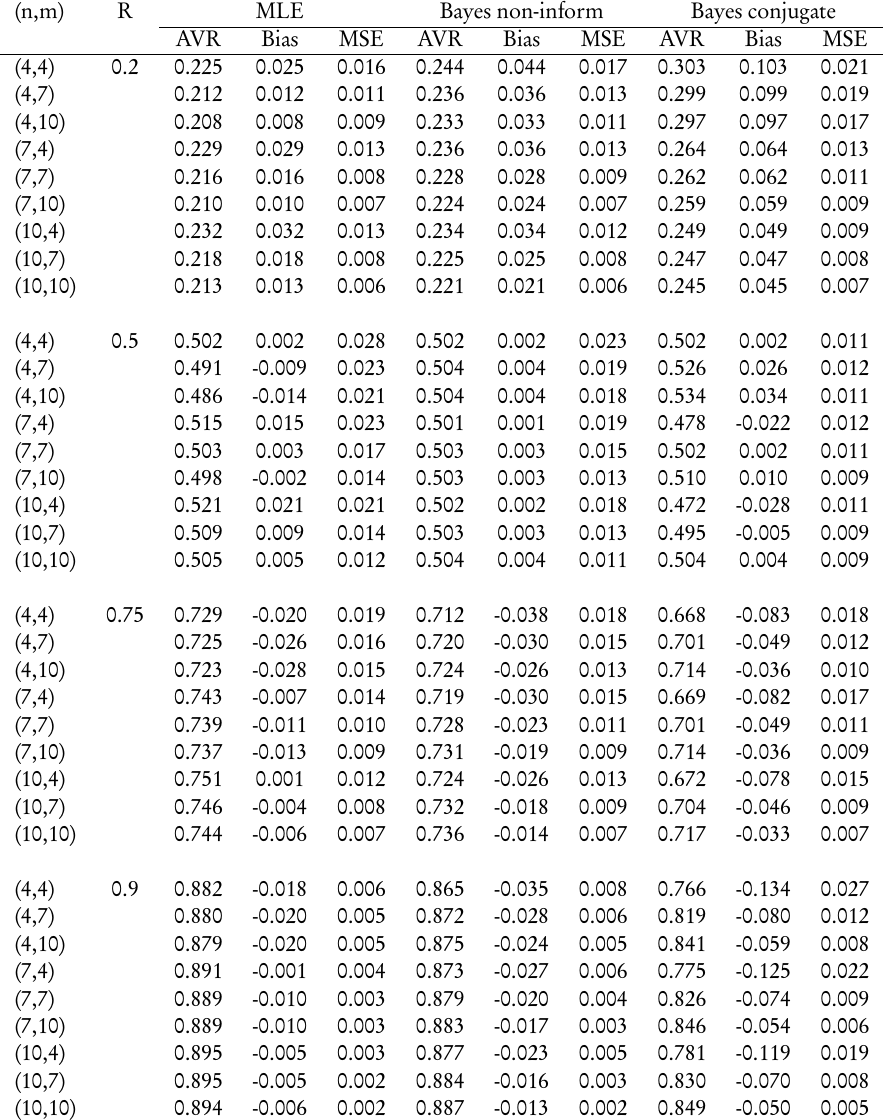
Average estimates (AVR), bias and MSE of the estimators of